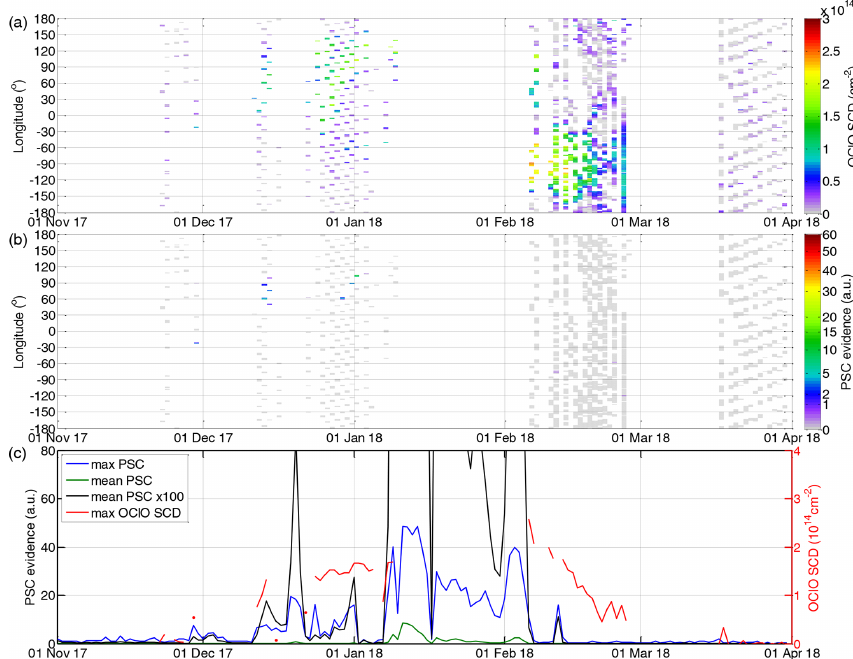
Figure 3. (a) Time series of OClO SCDs for 89 ◦ < SZA < 90 ◦ being collocated to CALIOP measurements and longitudinally resolved (resolution 1 ◦ , positive values – east longitudes, negative values – west longitudes) for the Arctic winter 2017/18. (b) Time series of the CALIOP PSC evidence collocated to the OClO SCDs in (a) . (c) Left axis: time series of maximum and mean PSC evidence for latitudes above 60 ◦ (blue and green lines, respectively), mean PSC evidence derived from the CALIOP PSC mask product scaled by 100 (black line); right axis: maximum OClO SCDs (red